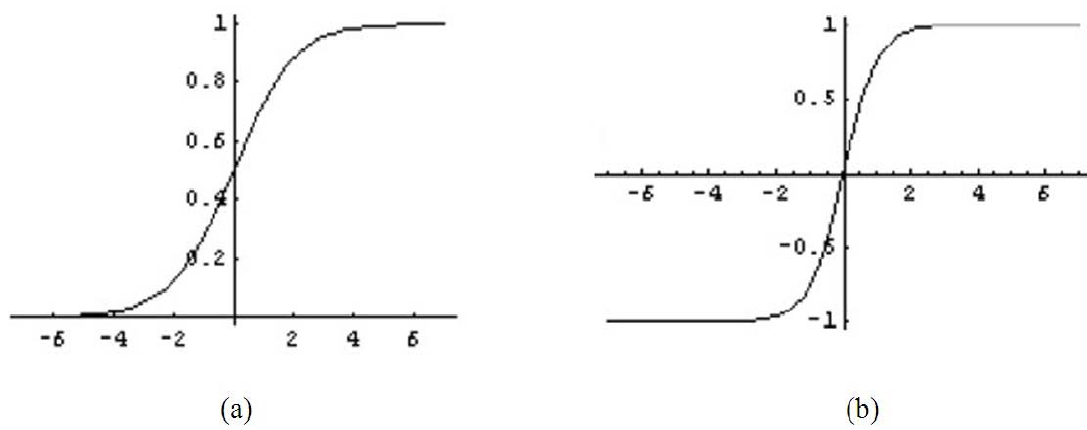
Figure 6. Activation function: ( a ) logarithmic sigmoid; and ( b ) hyperbolic tangent